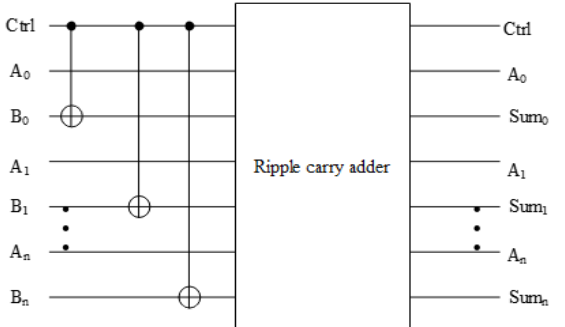
Figure 6. Quantum adder/subtractor for n qubits with T-count = 4 n , T-depth = 2 n and ancillae = n + 1 qubits [10].